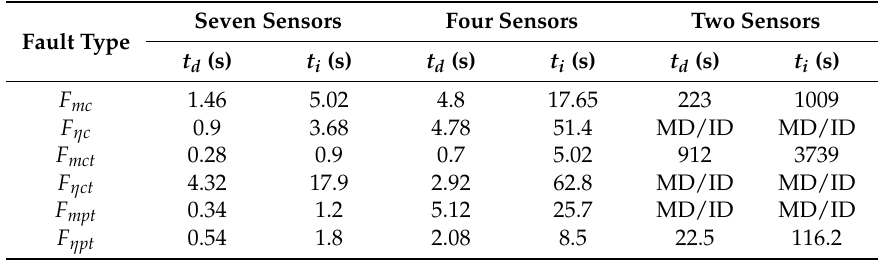
Table 6. The detection time and the isolation time for different numbers of measurements